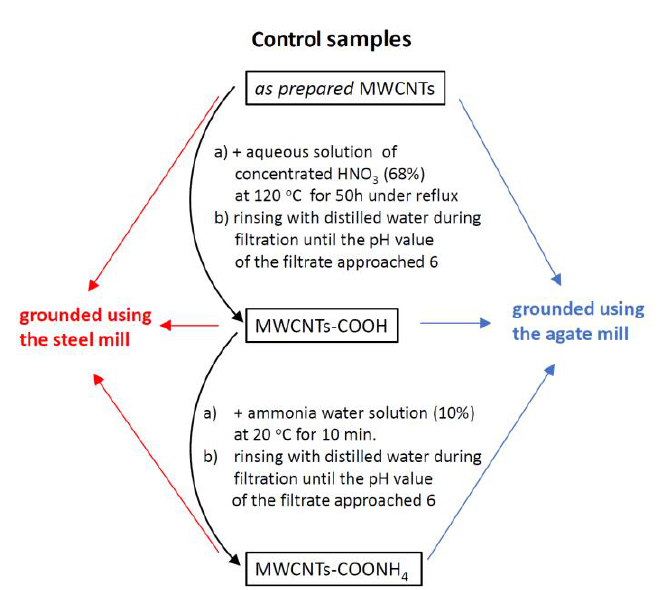
Figure 1. Steps of MWCNTs functionalization and their grinding.